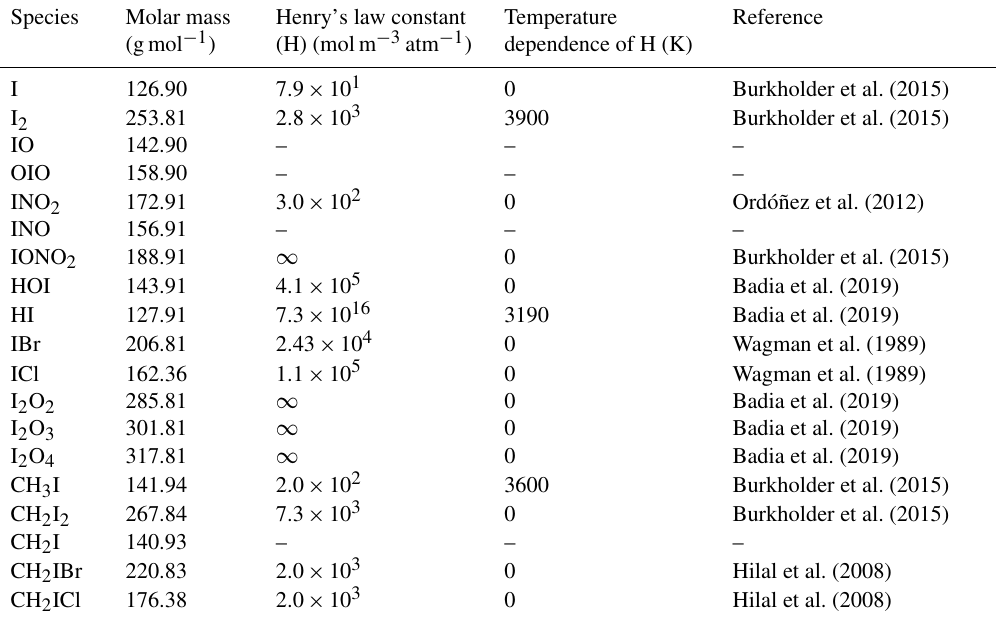
Table 2. The iodine species considered in